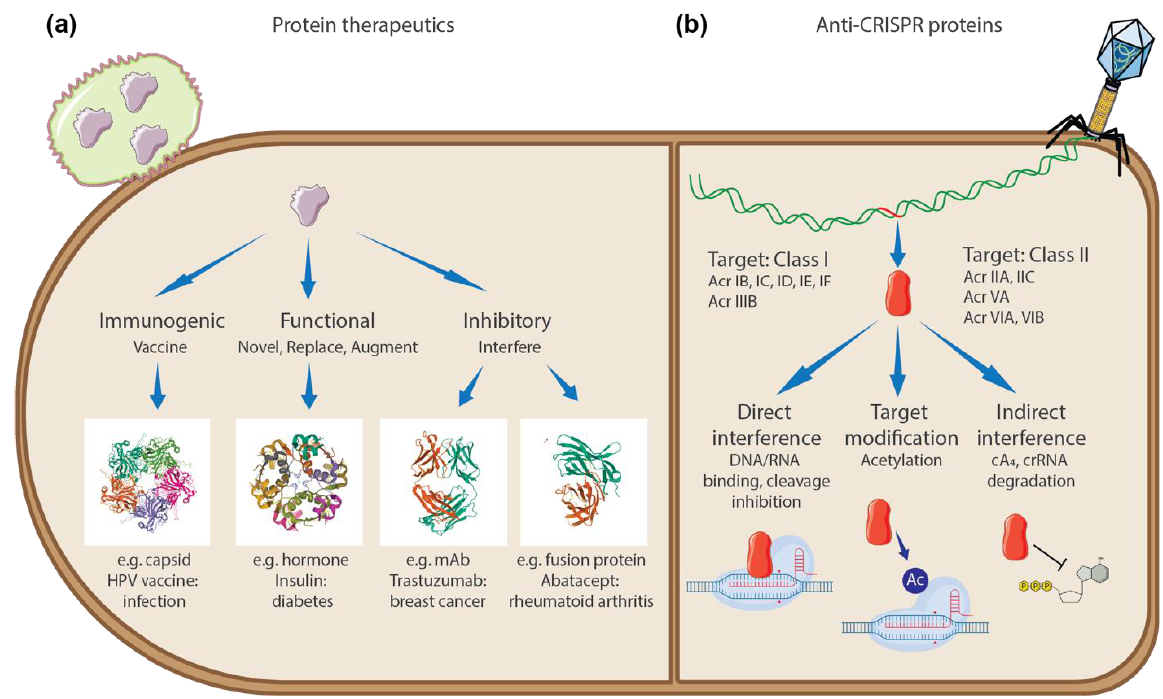
Figure 1. Mechanisms of protein therapeutics and anti-CRISPR proteins. ( a ) Mechanism of protein therapeutics. The first group consists of prophylactic or therapeutic vaccines that induce immunity against foreign or cancer cells. A highly successful protein vaccine against human papillomavirus (HPV) combining the capsids from four pathogenic HPV strains is given as an example (PDB: 2R5K [6]). The second group consists of protein therapeutics that provide novel functions, replace deficient or abnormal proteins, or augment existing activities. The approval of recombinant insulin in the 1980s to treat diabetes as the first abundant, inexpensive and low immunogenic therapeutic protein is given as an example (PDB: 4F8F [7]). The third group consists of proteins that interfere with target proteins through high binding specificity. Some monoclonal antibodies use antigen recognition sites or receptor-binding domains like Trastuzumab against breast cancer cells (PDB: 6MH2 [8,9]). Some fusion proteins inhibit target proteins by blocking interaction sites like Abatacept against rheumatoid arthritis (PDB: 1DQT [8,9]). ( b ) Mechanisms of anti-CRISPR proteins. Upon successful infection, phage genomes express anti-CRISPR proteins that neutralize host CRISPR-Cas immunity. Anti-CRISPR proteins target various types of both Class I and Class II CRISPR-Cas systems and the inhibitory mechanisms are highly diverse, including direct interference of DNA/RNA binding and cleavage of Cas complexes, enzymatic inhibition of the active site by acetylation, and nuclease activity of degrading the signalling molecule (cyclic nucleotide cA 4 ).